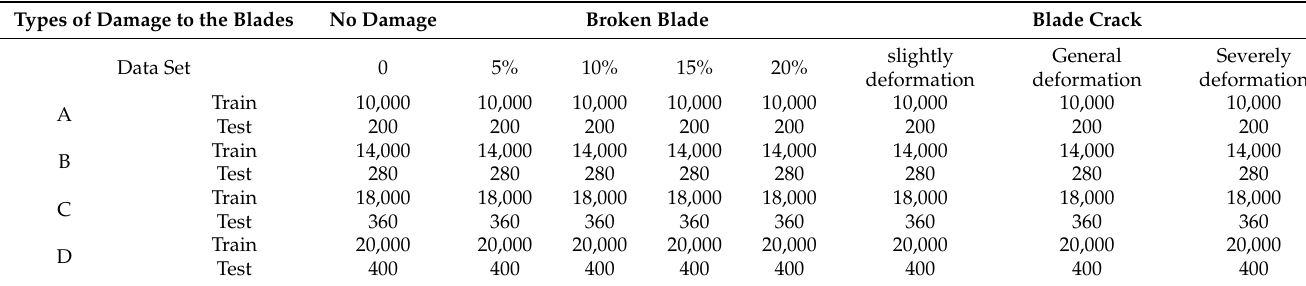
Table 2. Description of UAV datasets.